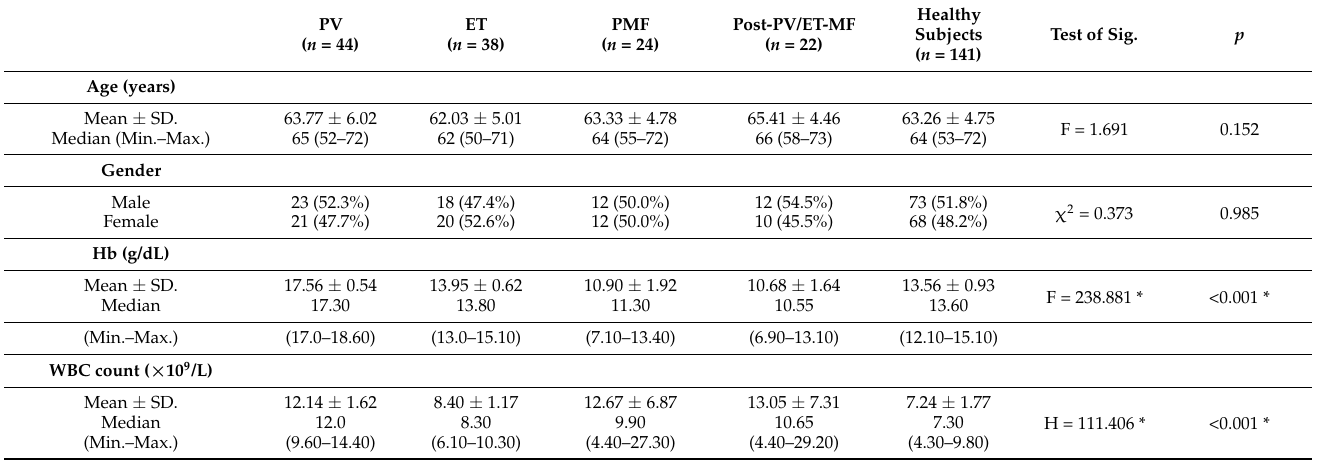
Table 1. Demographic, clinical, and laboratory data of Philadelphia-negative MPNs patients (at time of diagnosis) and healthy